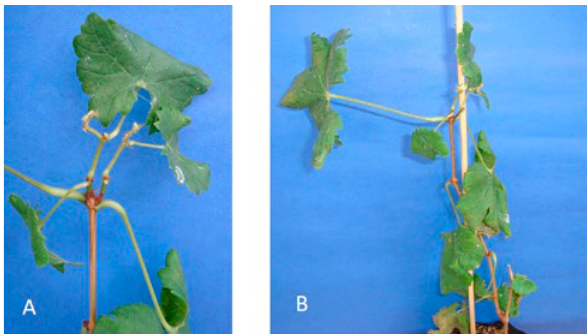
Figure 3. Symptoms associated with phytoplasma presence in grapevine after Paratanus exitiosus transmission. A) V43, short internodes; B) V76, leaves with downward rolling, deformations and